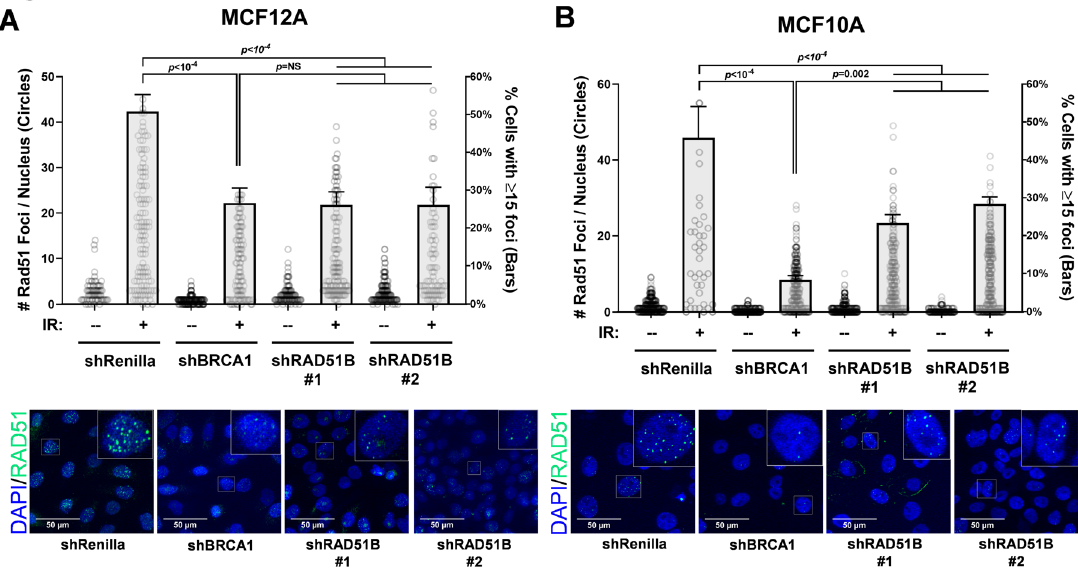
Fig. 3 Functional characterization of RAD51B-de fi ciency on ef fi ciency of homologous recombination. A , B RAD51 focus formation assay in MCF-12A and MCF-10A mammary epithelial cells expressing one of two independent RAD51B shRNAs, Renilla shRNA (nontarget control), or BRCA1 shRNA (positive control). Cells were plated onto eight-well chamber slides (EMD Millipore) and exposed to 10 Gy of ionizing radiation or mock irradiated (0 Gy). Nuclear RAD51 foci were visualized and quanti fi ed in two independent experiments (Supplemental Methods). Error bars represent standard error of mean